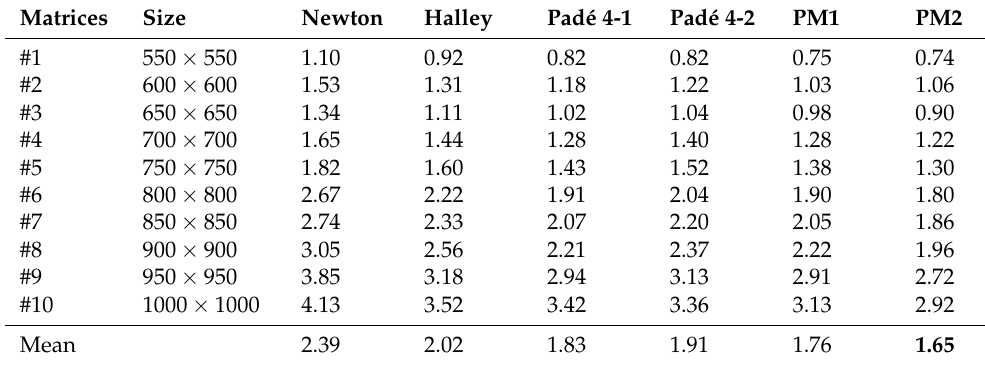
Table 4. Results of comparisons based on CPU time (seconds) for Experiment